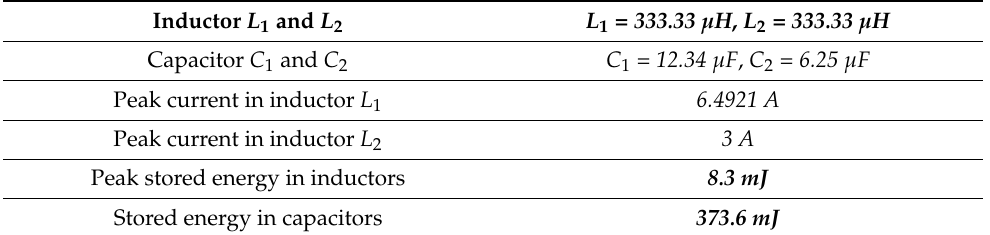
Table 6. Zeta converter results.